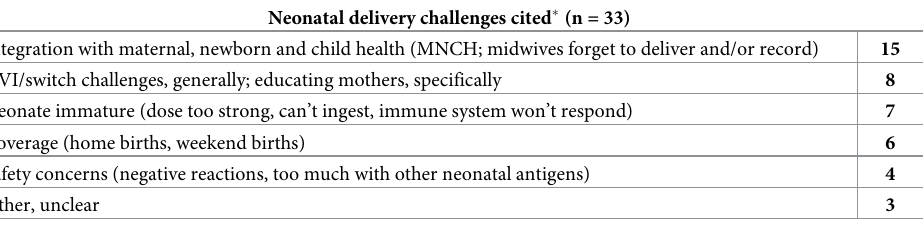
Table 6. Healthcare provider neonatal dose concerns by